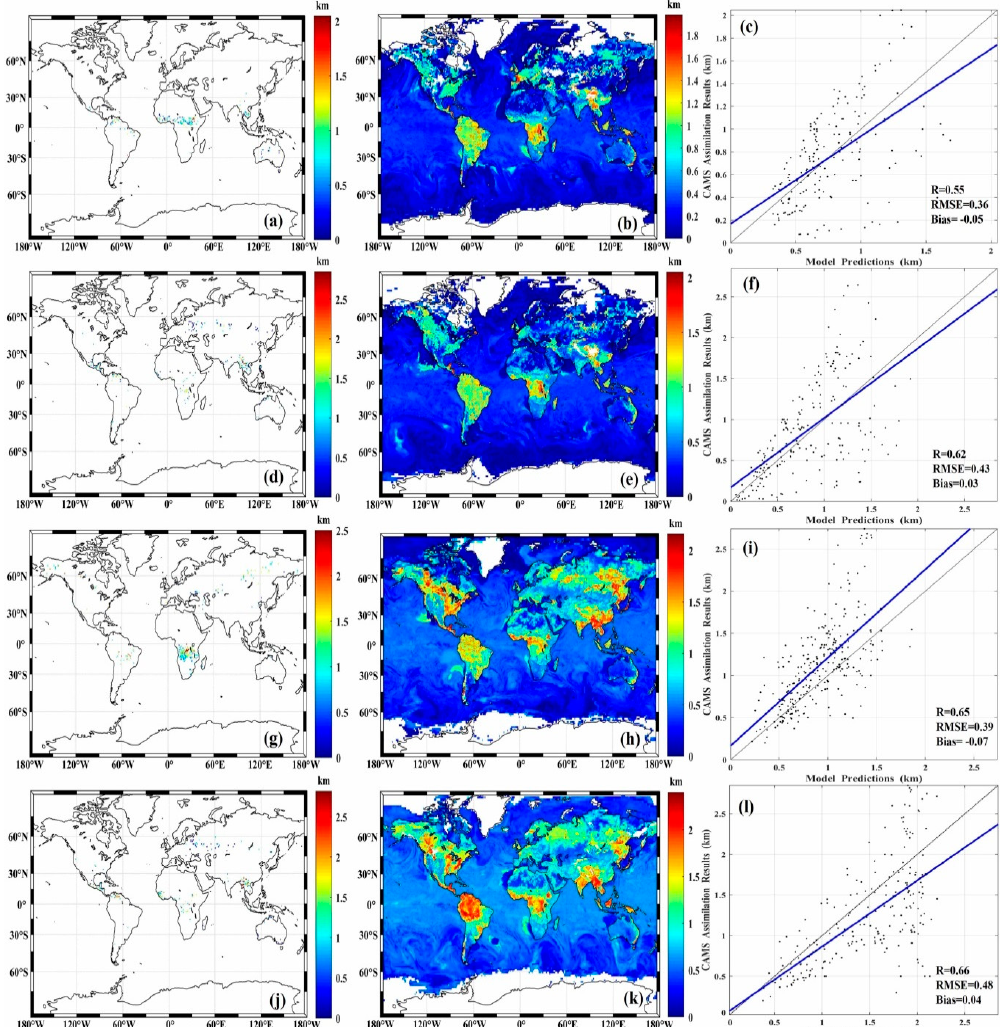
Figure 16. The validations on daily smoke aerosol MFA predictions. (a), (d), (g) and (j) are the mean altitude of biomass burning emissions injection derived by GFAS on 1st January 2019, 1st April 2019, 1st June 2019, and 1st October 2019, respectively; (b), (e), (h) and (k) are the model predicted smoke aerosol MFA on 1st January 2019, 1st April 2019, 1st June 2019, and 1st October 2019, respectively; (c), (f), (i) and (l) are the scattering plots comparisons of the dust aerosol MFA between model predicted and GFAS-derived mean altitude of biomass burning emissions injection on 1st January 2019, 1st April 2019, 1st June 2019, and 1st October 2019, respectively.